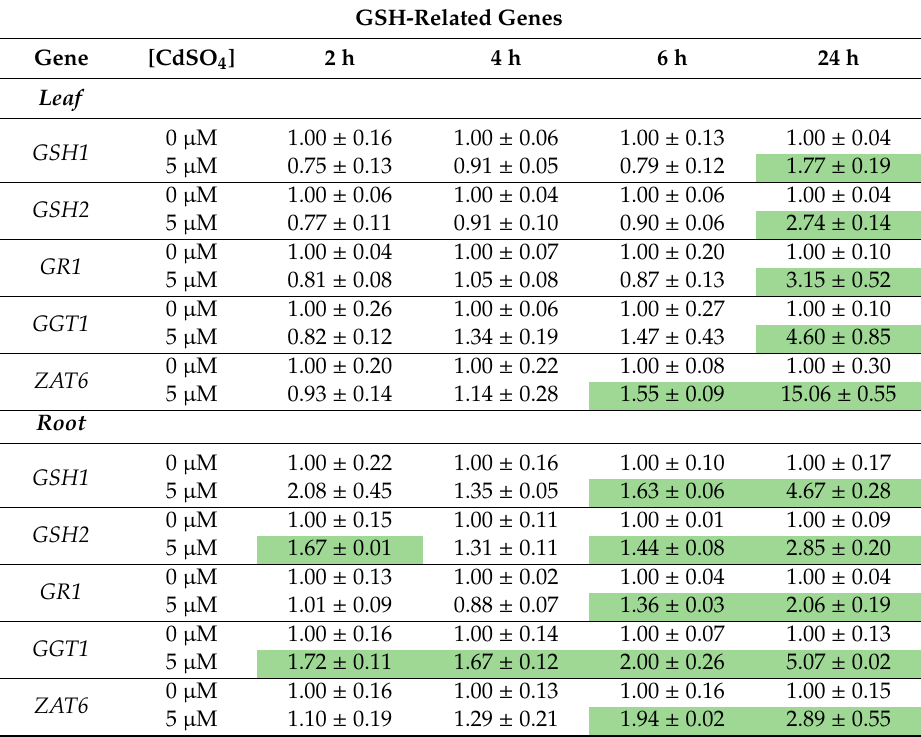
Table 2. Transcript levels of glutathione (GSH)-related genes in leaves and roots of Arabidopsis thaliana plants grown under control conditions (0 μM CdSO 4 ) or exposed to 5 μM CdSO 4 during 2 h, 4 h, 6 h and 24 h after 3 weeks of growth. For each time point, data are given as the mean ± S.E. of four biological replicates relative to the control set at 1.00. Significant differences ( t -test: p < 0.05) between control and exposed plants, within each time point, are marked in colour (upregulated: ). GSH1 : γ - glutamylcysteine synthetase; GSH2 : GSH synthetase; GR1 : glutathione reductase; GGT1 : γ -glutamyl transpeptidase 1; ZAT6 : zinc finger of Arabidopsis thaliana